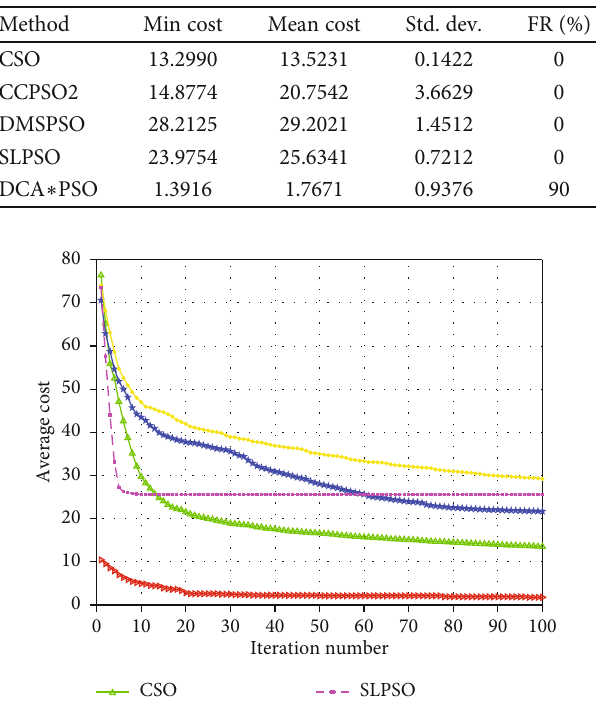
Table 5: The statistical results of di ff erent algorithms in case III.